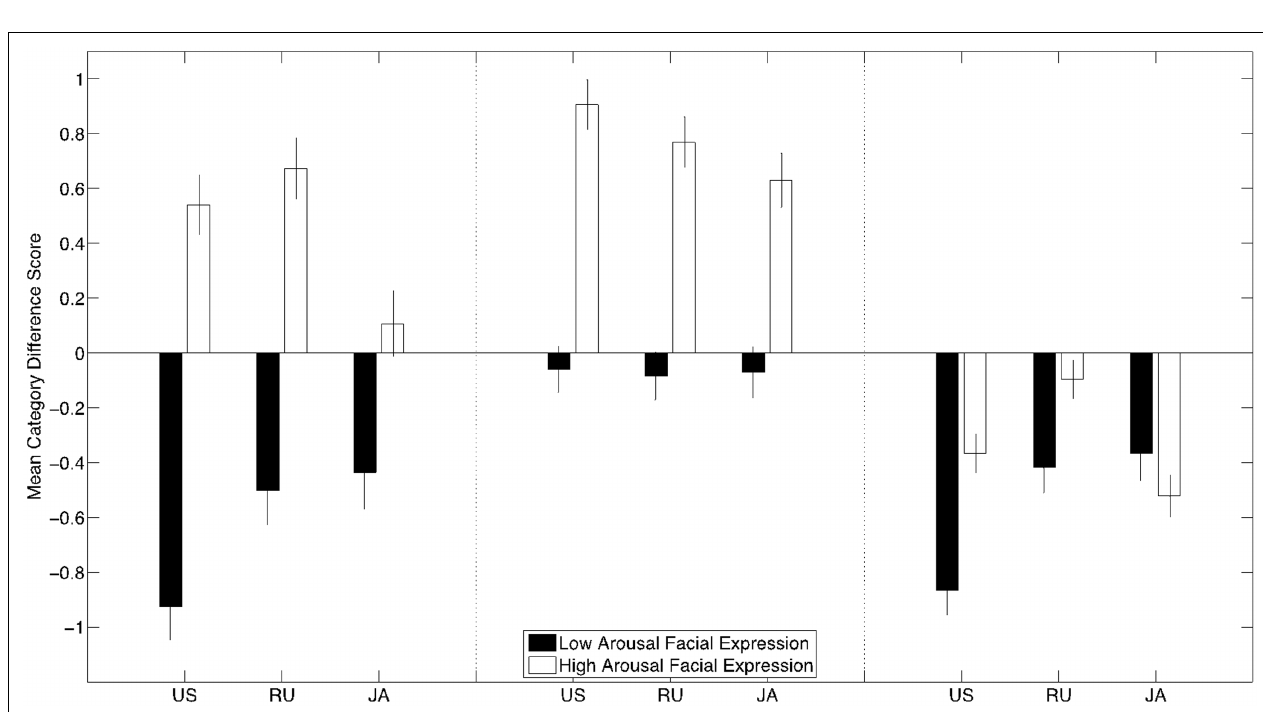
FIGUREA2 | Perceptual difference scores representing mean differences between ipsatized ratings for high compared to LA facial expressions in each intensity category across cultures. Significant cultural differences obtained from this additional analysis confirm those reported in the main paper and are listed in detail in TableA9 above.